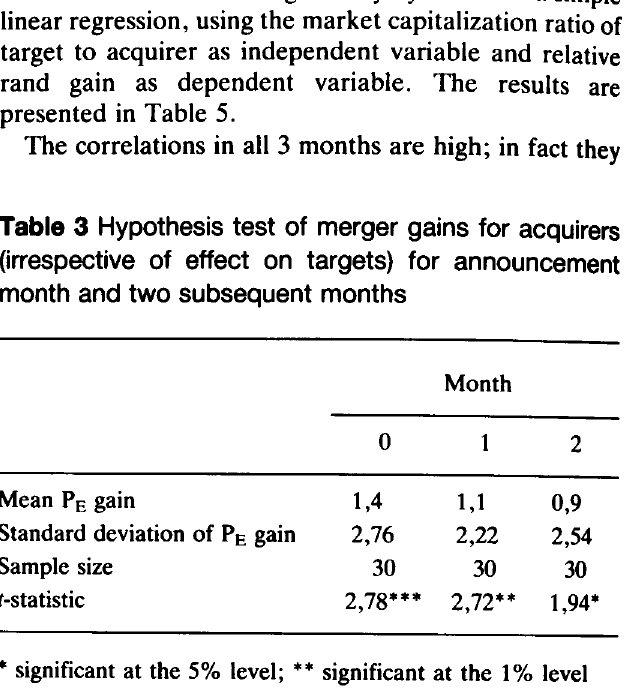
Table 4 Hypothesis test of merger gains for targets (irrespective of effect on acquirers) for announcement